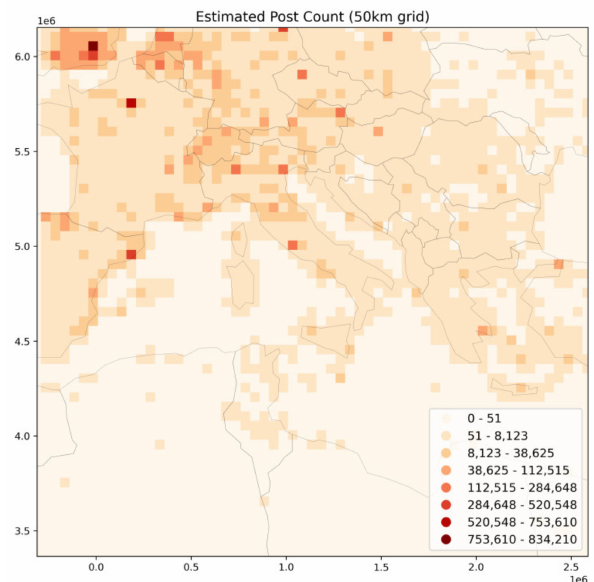
Figure 6. Estimated post count with a reduced grid size of 50 km for